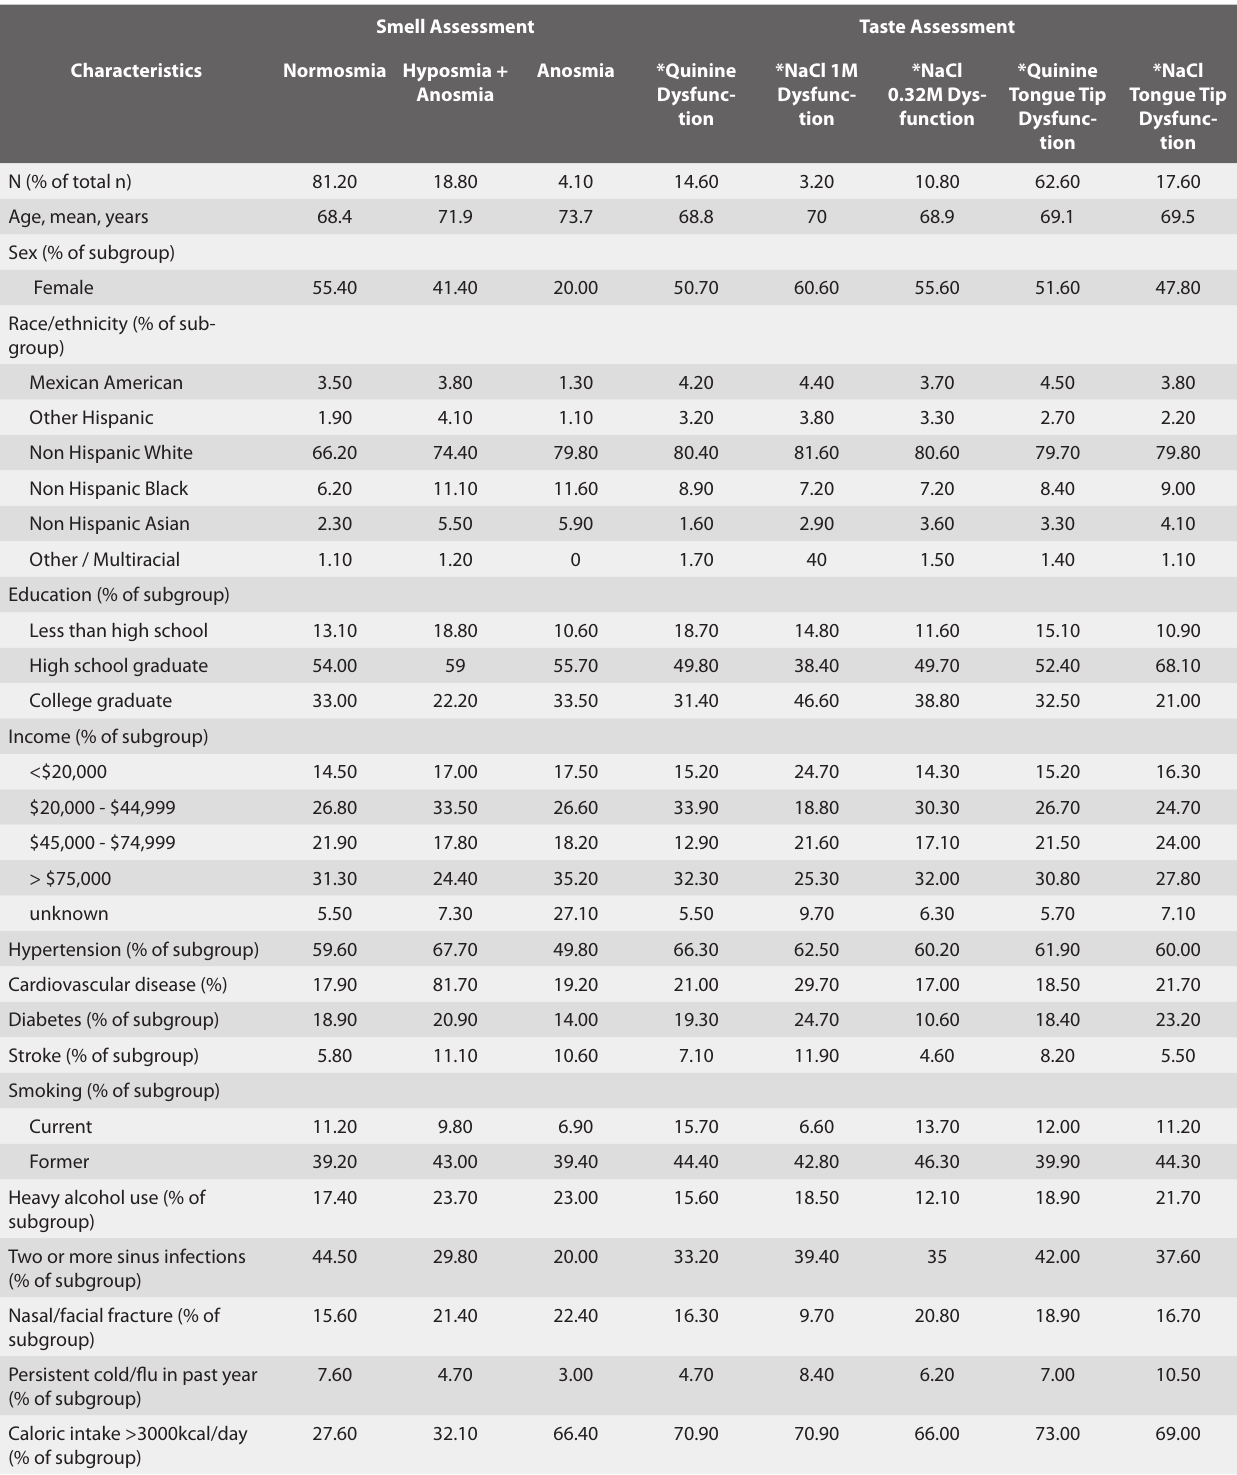
Table 1. Unweighted Cohort Characteristics, stratified by smell and taste